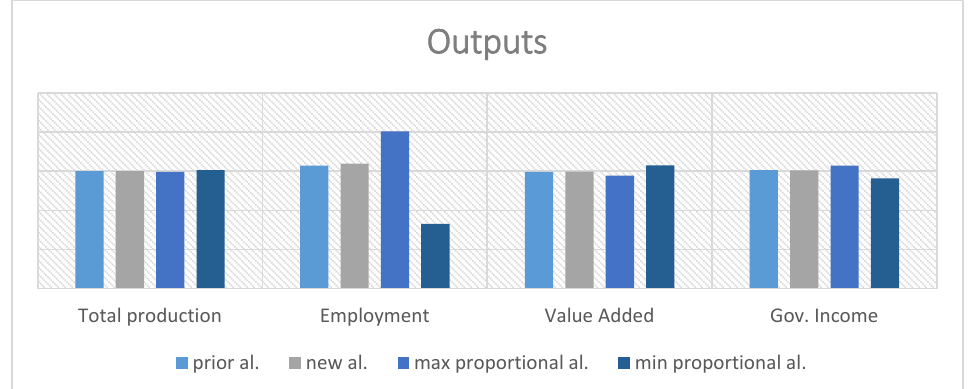
Fig. 3. The normalized amount of output indicators for the whole